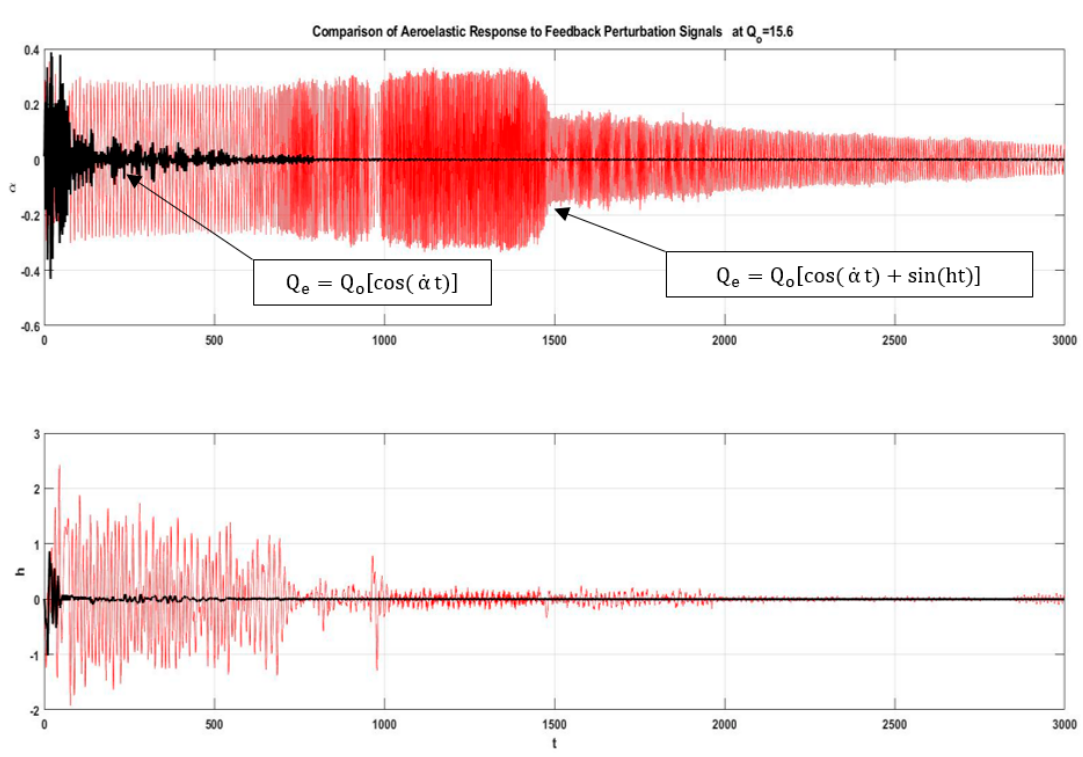
Figure 24. Instantaneous system damping.